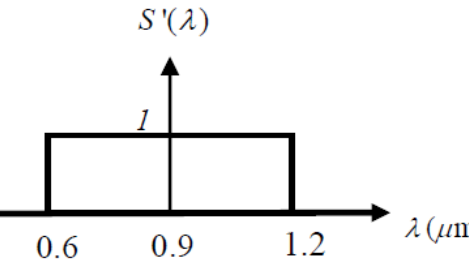
Figure 6. The spectral distribution and rectangle function of the incident spectrum.